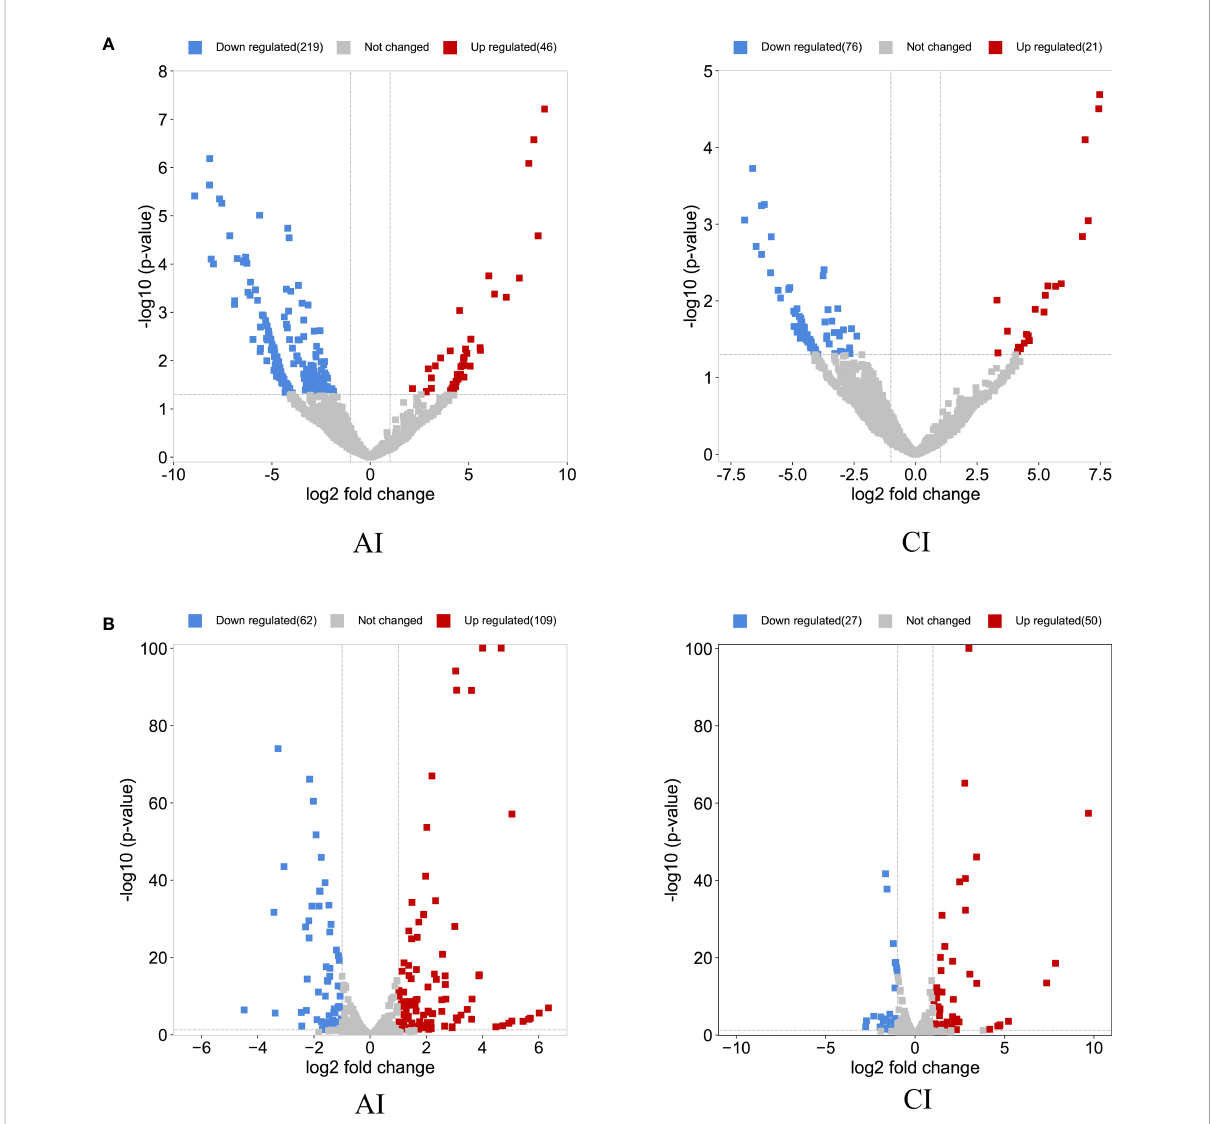
FIGURE 1 Overview of the differentially expressed (DE) circRNAs and DEmiRNAs. The volcano plots of DEcircRNAs (A) and DEmiRNAs (B) at acute infection (AI) and chronic infection (CI) stages. The horizontal-axis shows the log2 fold change, and the vertical-axis shows the -log10 p-value. The up- regulated are marked in red and the down-regulated RNAs are in